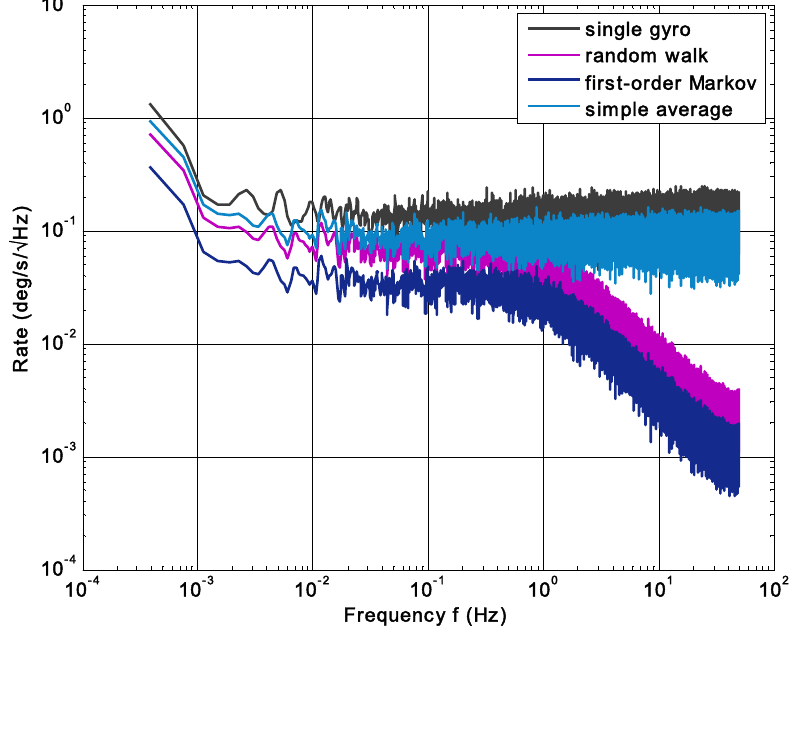
Figure 5. FFT plot of the virtual gyroscope compared to the single gyroscope and averaging outputs of the gyroscope